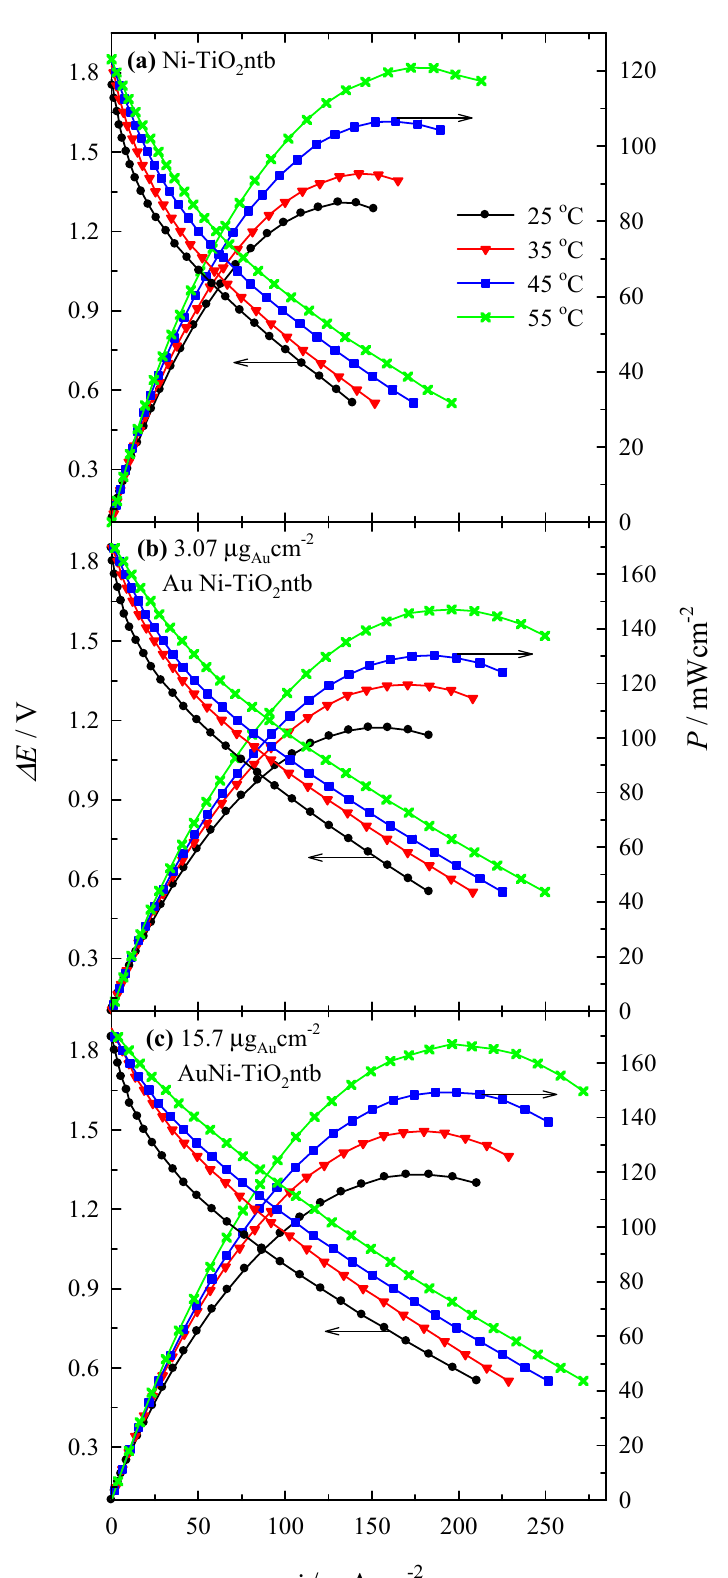
Figure 13. Cell polarization and power density curves for the NaBH 4 -H 2 O 2 fuel cell using Ni-TiO 2 ntb and AuNi-TiO 2 ntb as anode catalysts at different temperatures. Anolyte consisted of 1 M NaBH 4 + 4 M NaOH and catholyte consisted of 5 M H 2 O 2 + 1.5 M